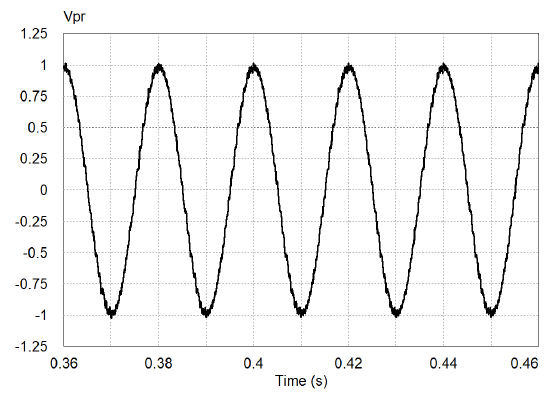
Figure 22. Steady-state primary voltage (Vpr) during loss of synchronism with different switching